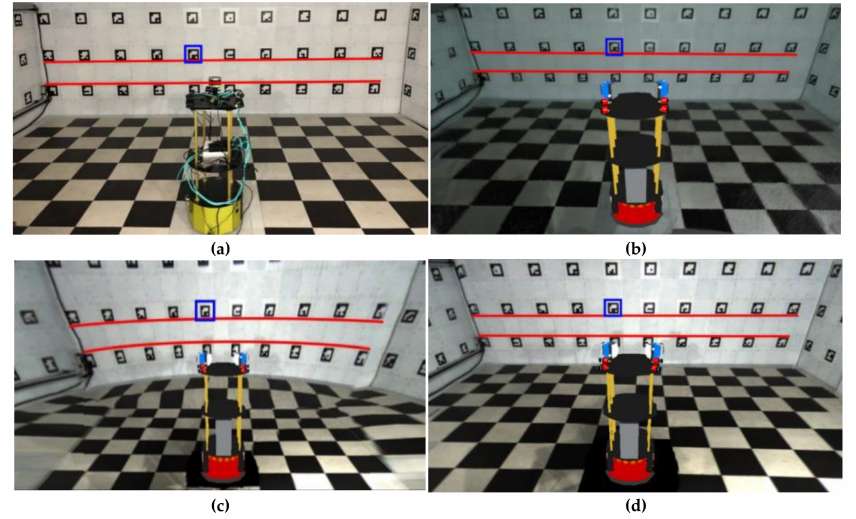
Figure 16. Resulting images in various and complex